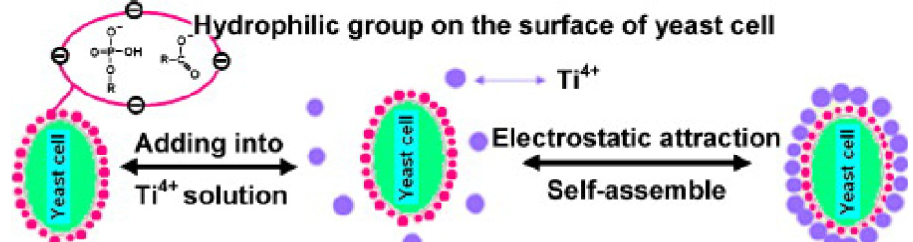
Fig. 6. Typical biosynthesis process of NTPs formation involving yeast cells, reprinted with permission from J. Cui, W. He, H. Liu, S. Liao and Y. Yue // Colloids Surfaces B Biointerfaces. 74 (2009) 274, (c) 2009